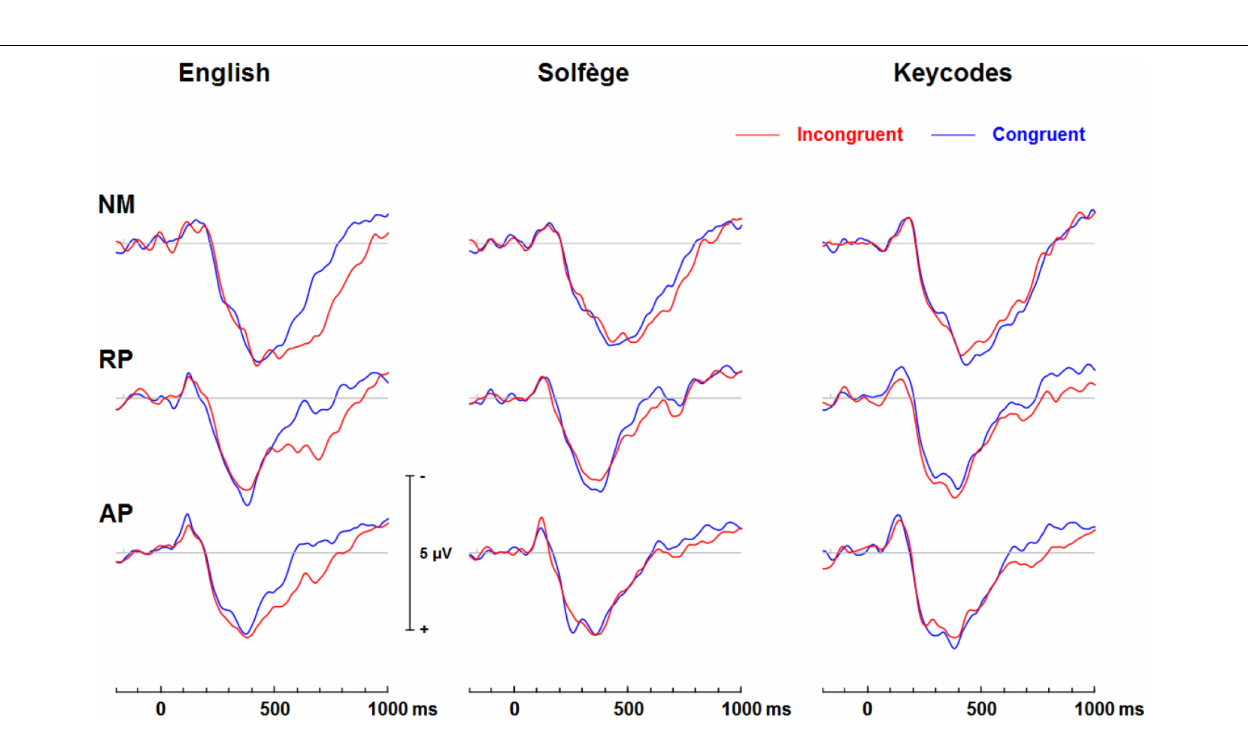
FIGURE 4 | Event-related potential waveforms at the midline parietal (Pz) electrode site showing a posterior late positive complex (LPC) wave that significantly differs in amplitude at late stages of processing for congruent and incongruent word form conditions, which may reflect a post-trial motor response awareness. English words elicit significant congruence effects but only AP shows significant LPC differences for